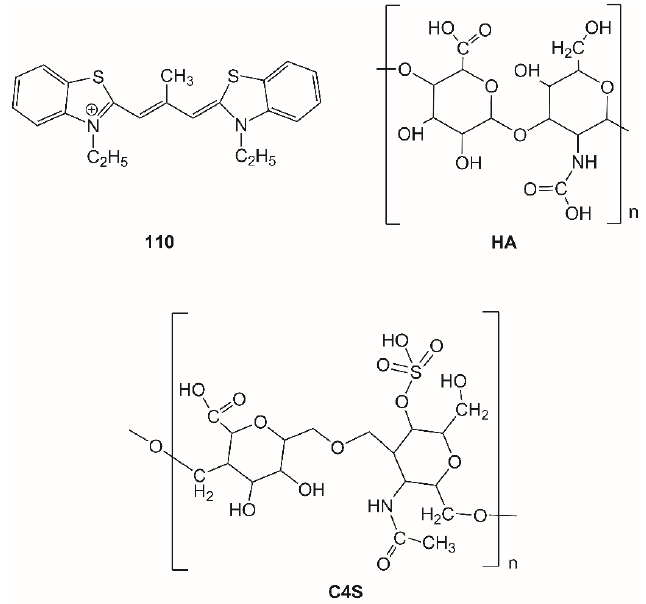
Figure 21. Structures of cyanine dye 110, hyaluronic acid (HA) and chondroitin ‐ 4 ‐ sulfate (C4S). The interaction of trimethine cyanine dyes 53 (DEC) and 1 (Cyan 2) with biological surfactants—including bile salts sodium cholate, sodium deoxycholate, and sodium